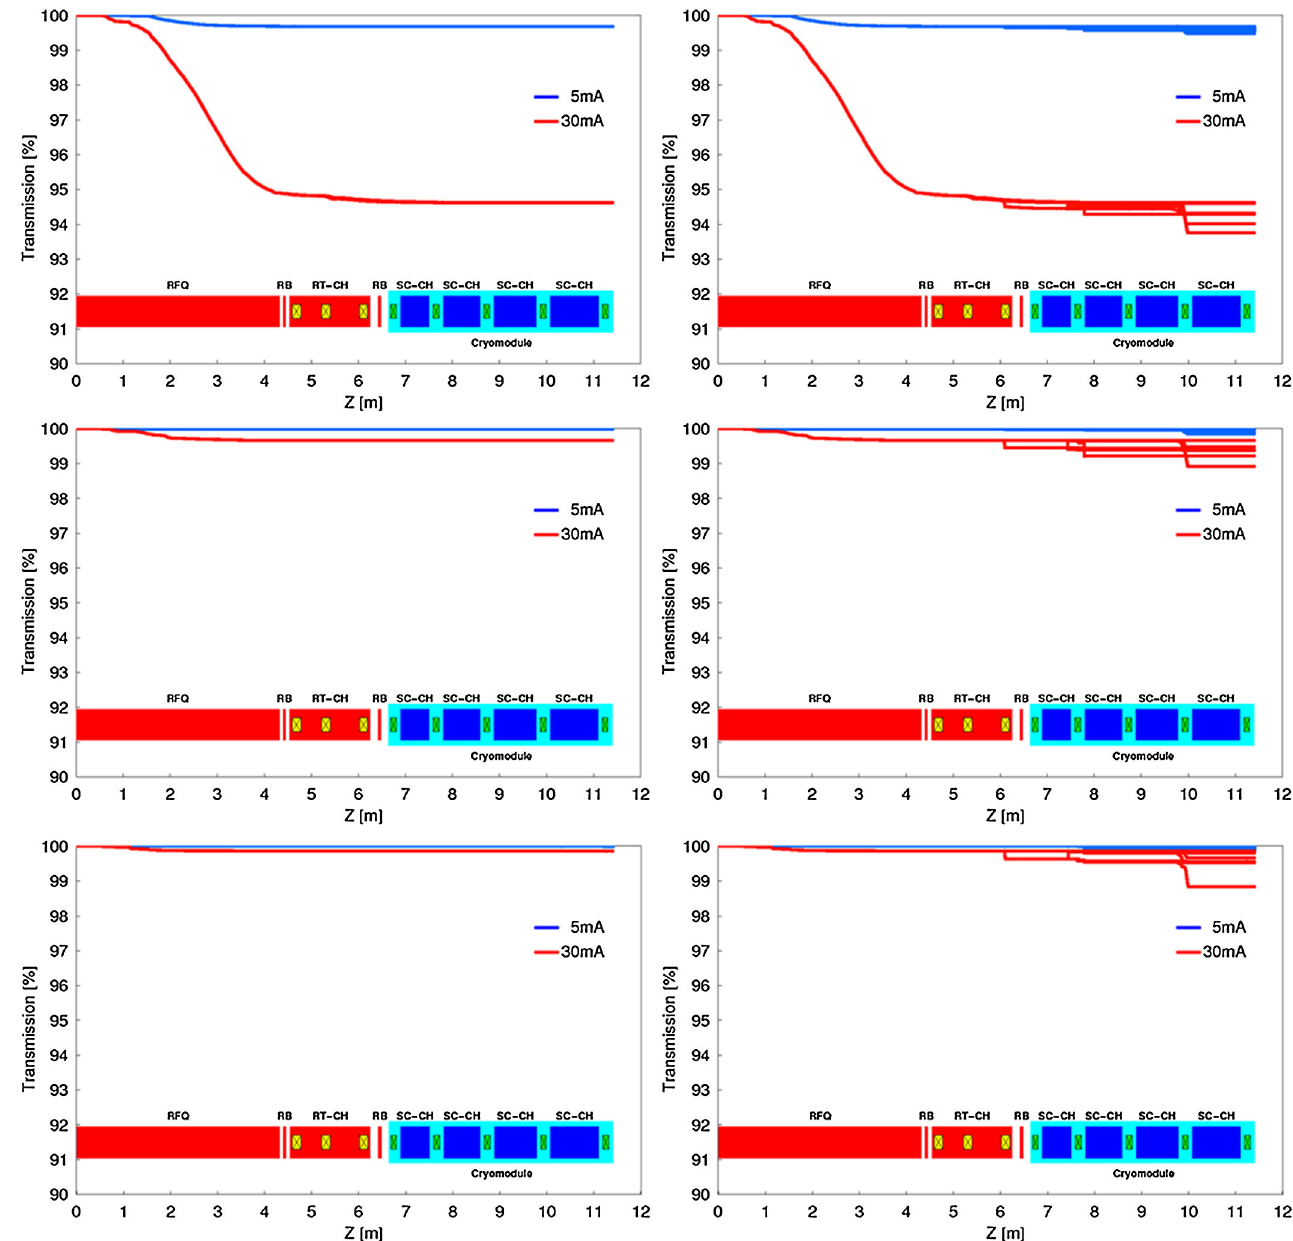
¼ (cid:3) 5% ; middle: vane